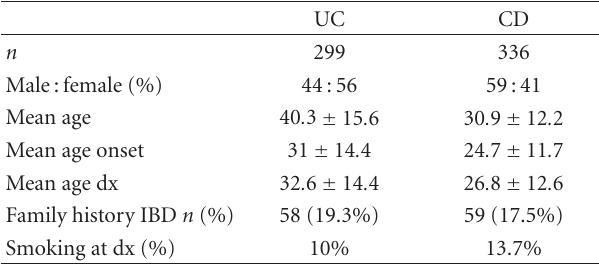
Table 1: General characteristics of the Registry patients.